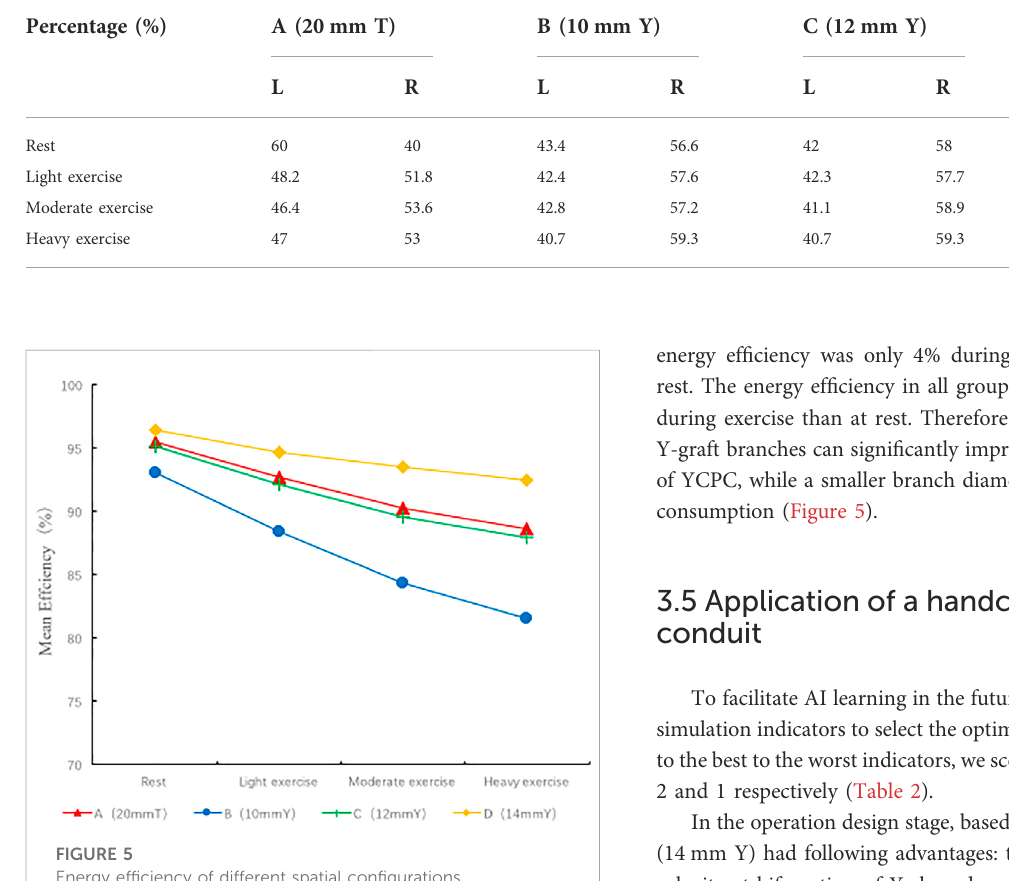
FIGURE 5 Energy ef fi ciency of different spatial con fi